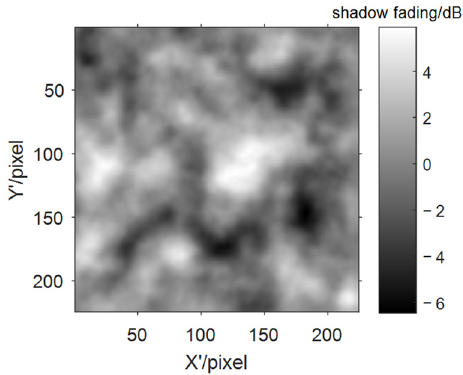
Figure 6. An example for shadow fading map.